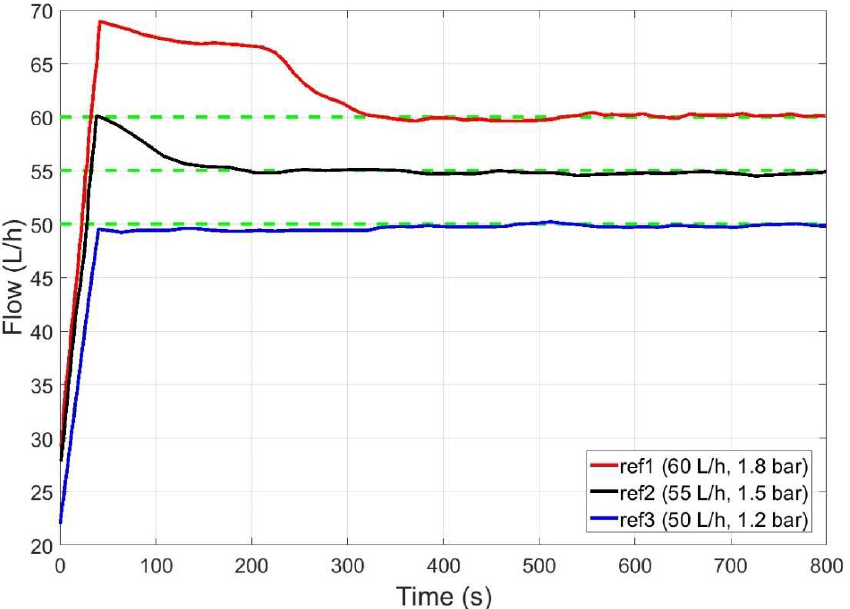
Figure 11. Controller performance for flow rate at different operating points defined by flow rate and pressure (flow references are marked in dashed green in all cases).